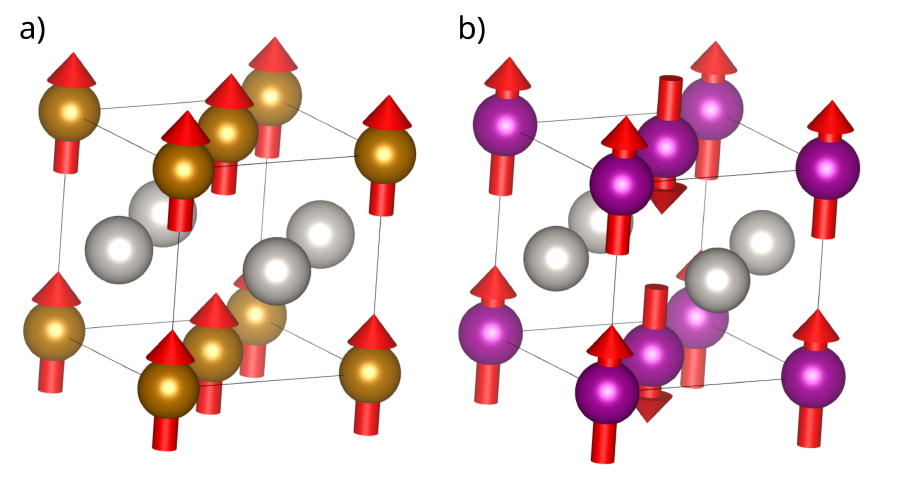
Figure 5. ( a ) The ground-state magnetic and geometric structure of FePt. ( b ) The ground-state magnetic and geometric structure of PtMn. Brown atoms are Fe, purple atoms are Mn and silver are Pt. Note that the major difference between these structures is in the magnetic coupling between the Fe atoms and the Mn